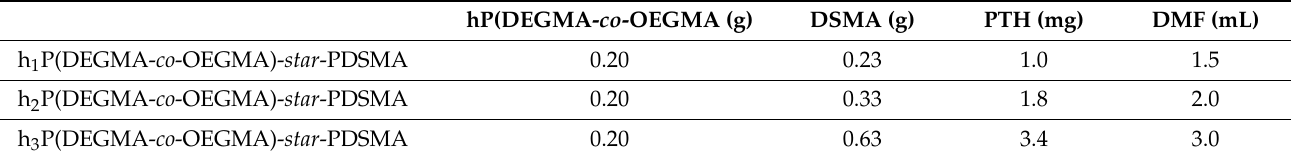
Table 2. Polymerization recipe of three hyperbranched multiarm copolymers polymers. hP(DEGMA- co -OEGMA (g) DSMA (g) PTH (mg) DMF (mL) h 1 P(DEGMA- co -OEGMA)- star -PDSMA 0.20 0.23 h 2 P(DEGMA- co -OEGMA)- star -PDSMA h 3 P(DEGMA- co -OEGMA)- star -PDSMA